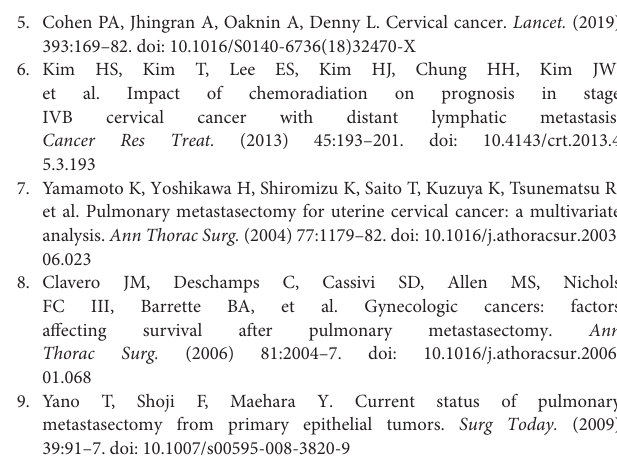
Supplementary Figure 1 | Flow chart of the process of data extraction from the SEER database. Supplementary Figure 2 | Screen capture of the X-tile software for the cutoff point